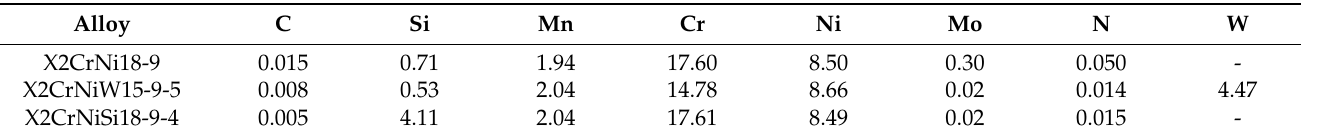
Table 1. Chemical composition of the investigated steels, shown as a mass percentage. Values were measured by optical emission